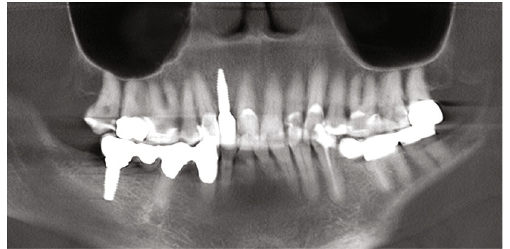
Figure 19: CB-CT after completion of the surgical and implant prosthetic